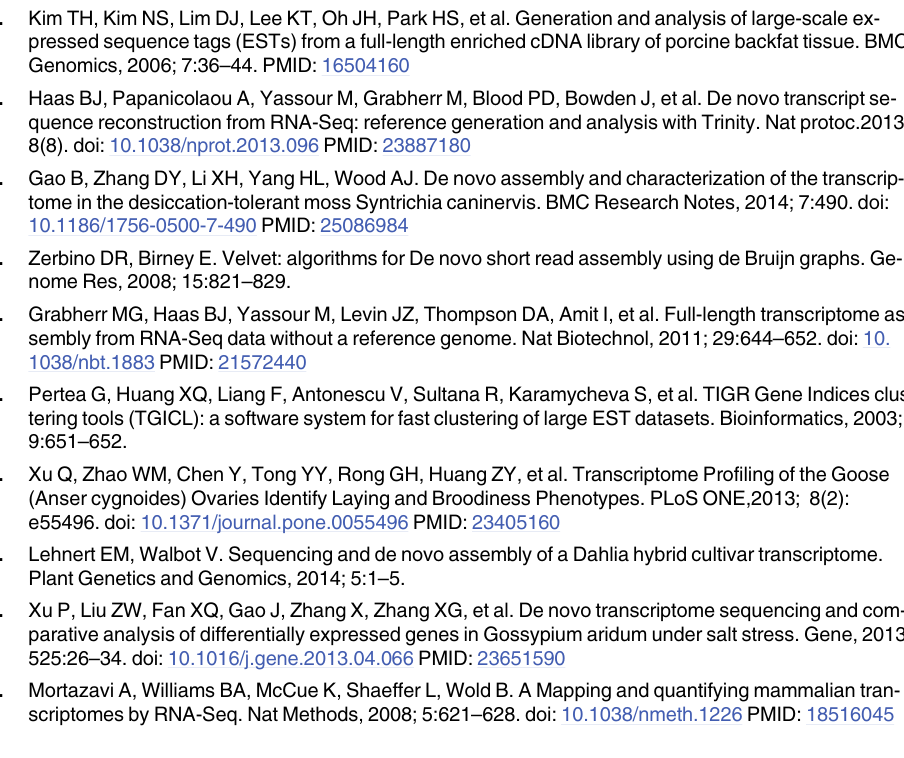
S2 File. Table A, The GO information about 99 known genes. Table B, The expression of dif- ferential expressed novel genes (four sheets). Table C, The pathway enrichment of genes. Table D, KEGG pathways of differentially expressed